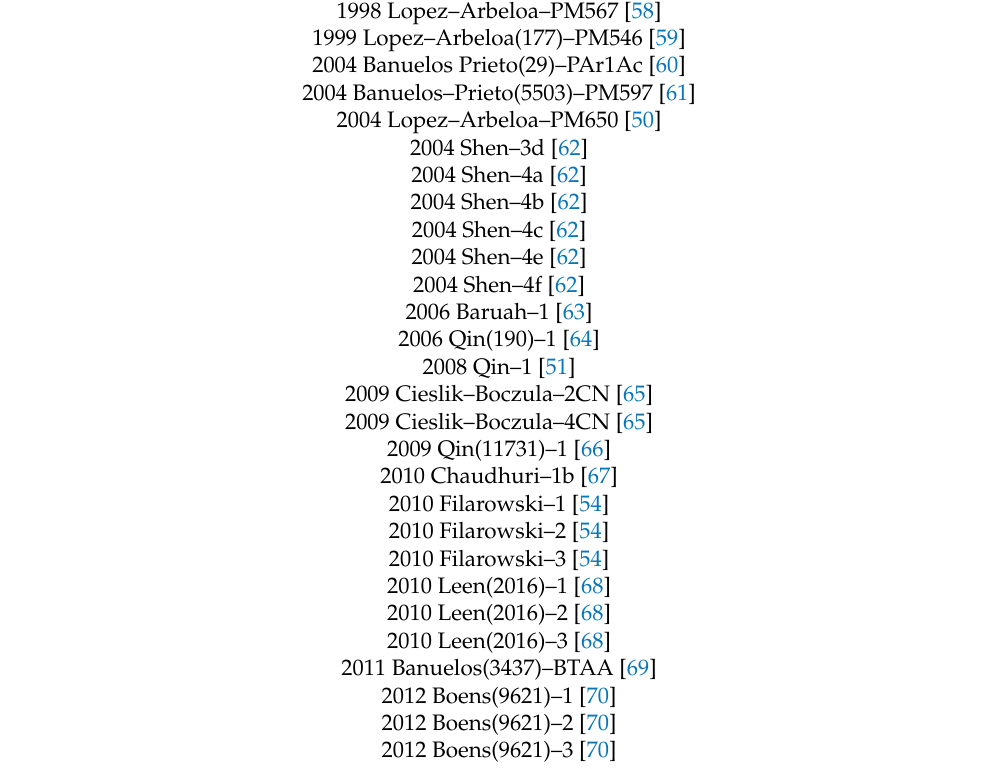
Table 1. List of dyes selected for the